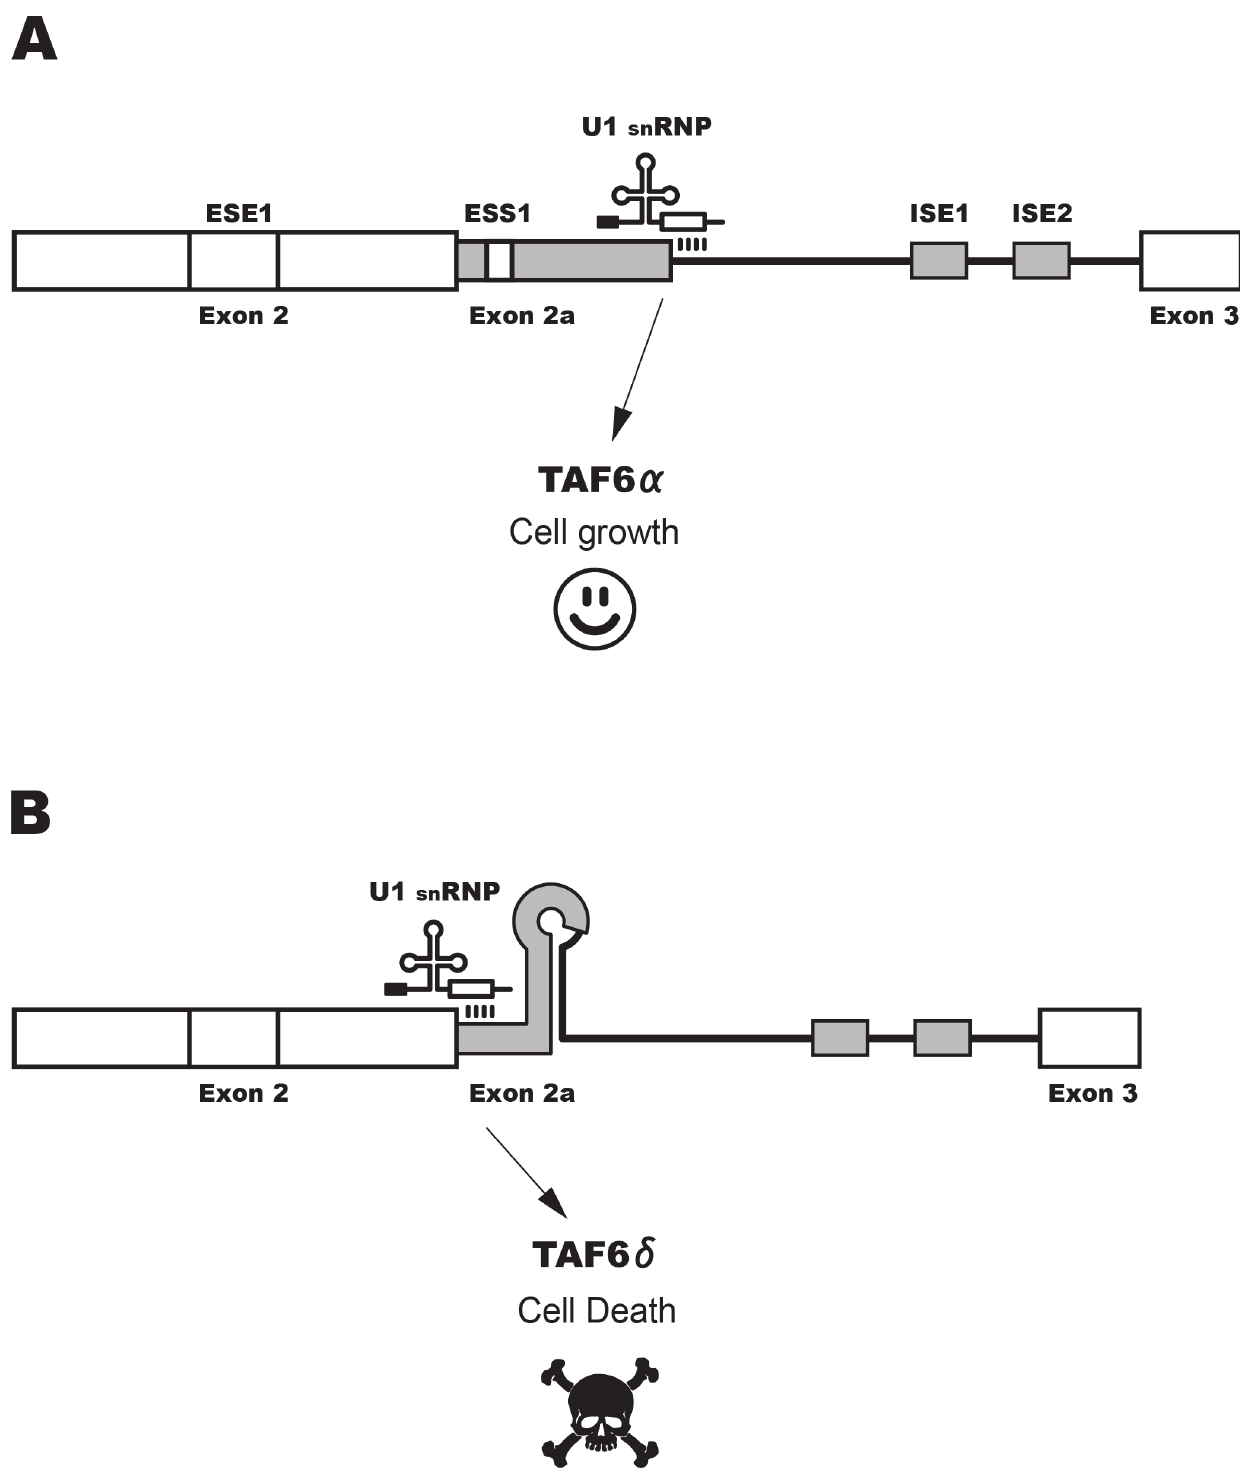
Figure 8. A hypothetical model for TAF6 d alternative splicing. (A) The TAF6 minigene construct is schematically shown with putative exonic splicing enhancer (ESE), exonic splicing silencer (ESS) and intronic splicing enhancer (ISE) motifs indicated with boxes. Enhancer or silencer definitions are given with respect to the pro-apoptotic TAF6 d isoform but likely act simultaneously to repress one 5 9 SS while enhancing the other because of the small distance (30 nucleotides) between them. (B) As in panel A, except that mutations were focused on poly G motifs found within intron 2.